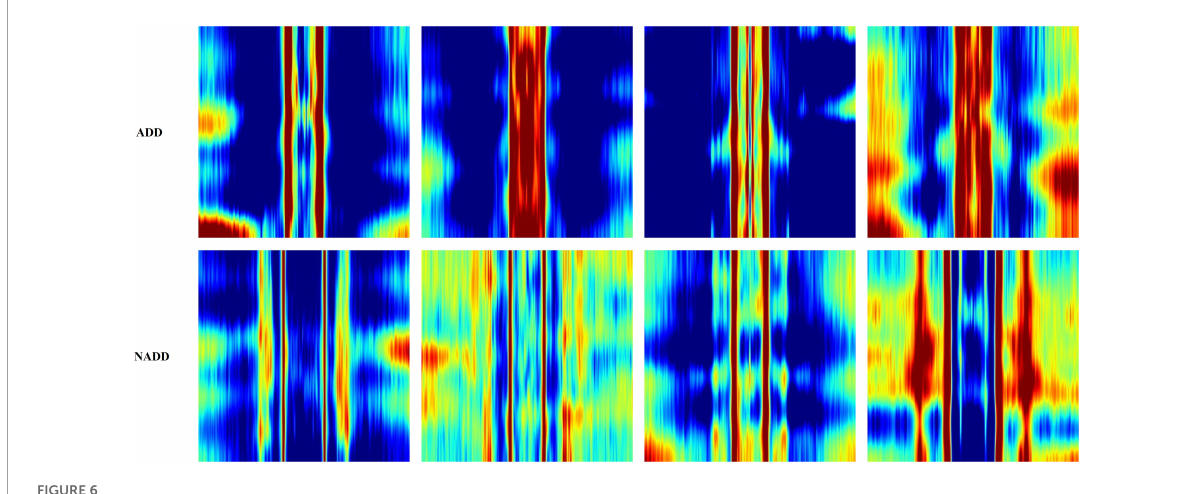
FIGURE6 Typical feature images representing the classes Alzheimer’s disease dementia (ADD) and non-Alzheimer’s disease dementia (NADD).